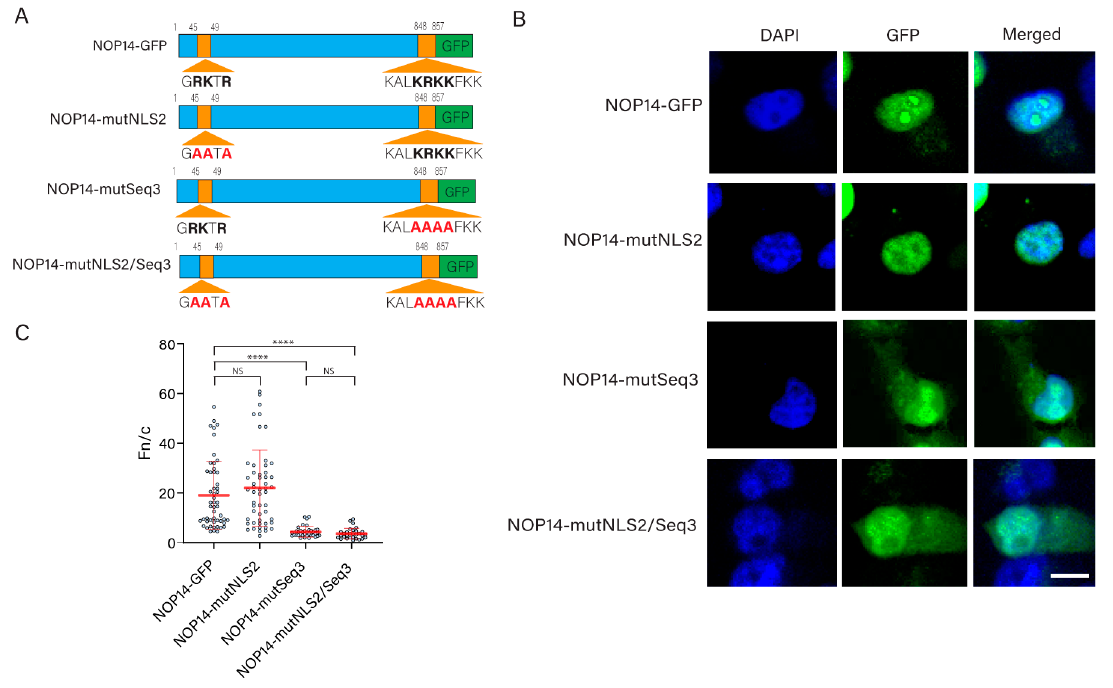
Figure 6. Functional analysis of NLS2 and a predicted NLS of NOP14. ( A ) Schematic representation of the chimeric proteins NOP14-mutNLS2, NOP14-mutSeq3, and NOP14-mutNLS2/Seq3 fused to GFP. Basic residues of NLS2 and Seq3 are indicated in bold. The amino acids in red indicate substitutions from the WT NOP14 sequence. ( B ) Confocal images of HeLa cells transfected with plasmids expressing the proteins shown in A 24 h post-transfection. Nuclei were stained with DAPI. Scale bar, 10 μ m. ( C ) Quantification of the ratio of nuclear to cytoplasmic fluorescence (Fn/c) from the experimental conditions shown in B. Shown is the means ± standard error of the means scored from 85–100 cells for each condition from three independent experiments. (NS, not significant; **** p < 0.0001, one-way ANOVA followed by Tukey’s tests).